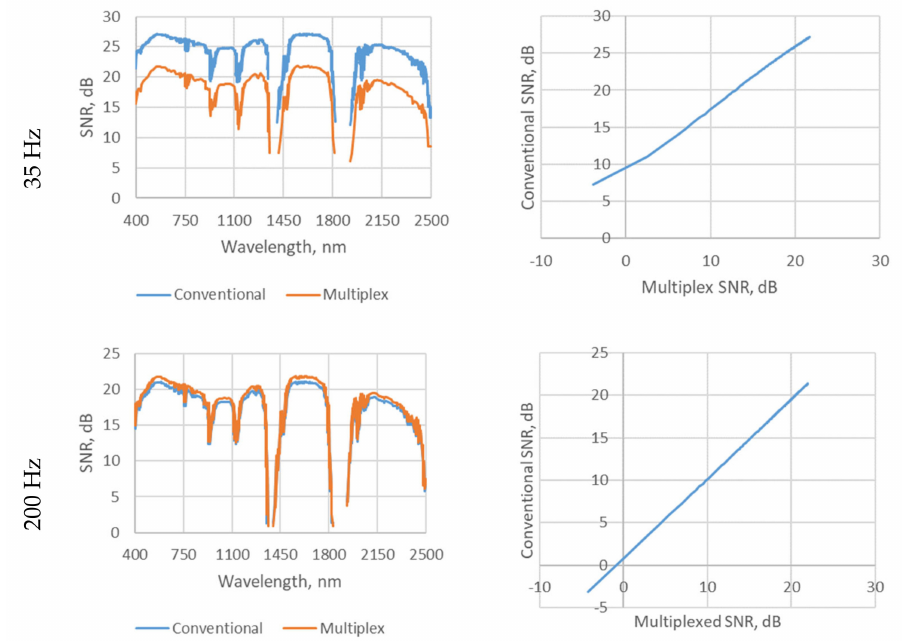
Figure 6. Depicts the variation of the SNR for the conventional and multiplexed SNRs as a function of wavelength ( left ) and SNR magnitudes ( right ), for frame rates at 35 Hz ( top ) and 200 Hz ( bottom ). The detector is a Teledyne Chroma array with 480 bands, at low illumination angle of 70 ◦ from zenith and f/2.5